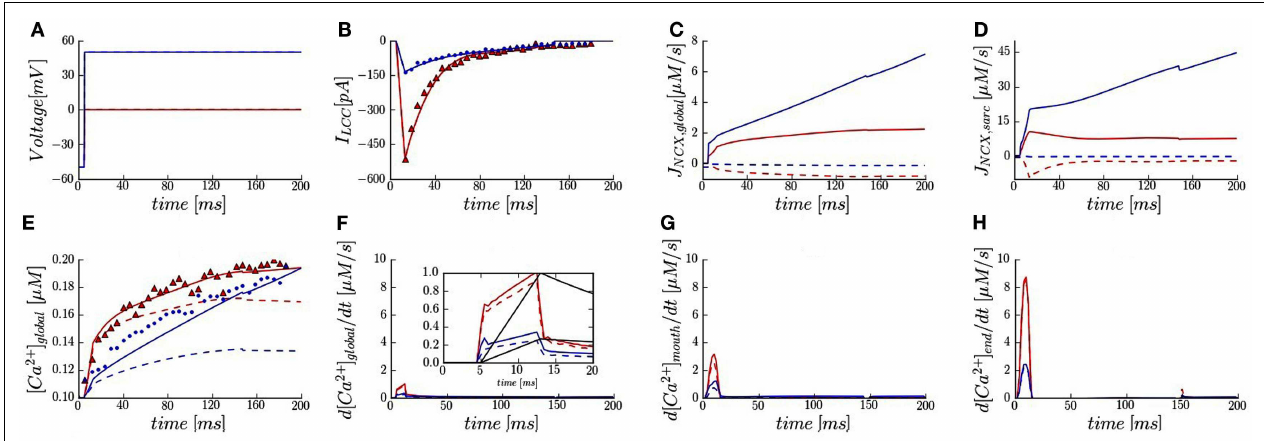
trigger fluxes from global Ca 2 + transient. Inset shows normalized whole-cell LCC currents ( black lines ) and normalized trigger fluxes at 0 and + 50mV. (G,H) Local Ca 2 + trigger fluxes at 1.5 and 5.3 µ m ( green spots in Figure 1B ). Membrane voltage at 0mV ( red lines and symbols ) and at + 50mV ( blue lines and symbols ). [Na + ] i 10mM ( solid lines ) and [Na + ] i 0mM ( dash lines ).